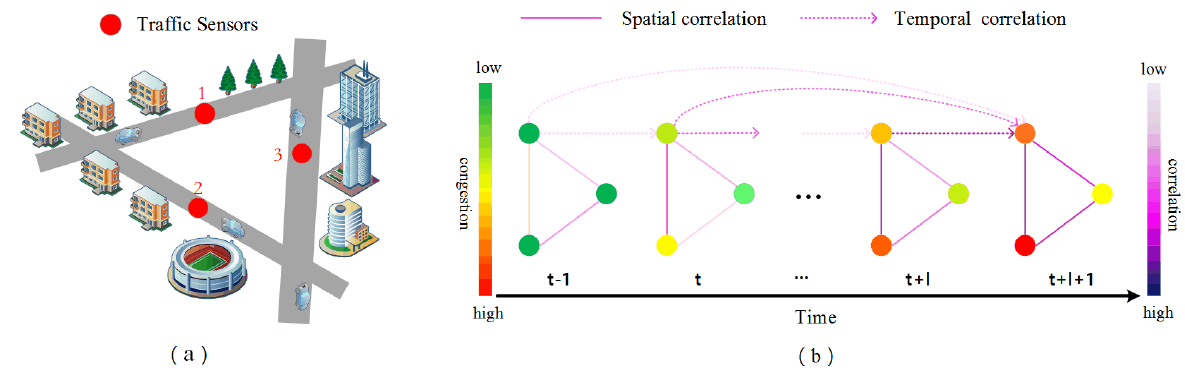
Figure 1. Spatial-temporal correlation is dominated by the road network structure. ( a ) a road network, where the red dots numbered 1 to 3 represent road network traffic sensors; ( b ) the traffic signal tensor map from time t − 1 to time t + l +